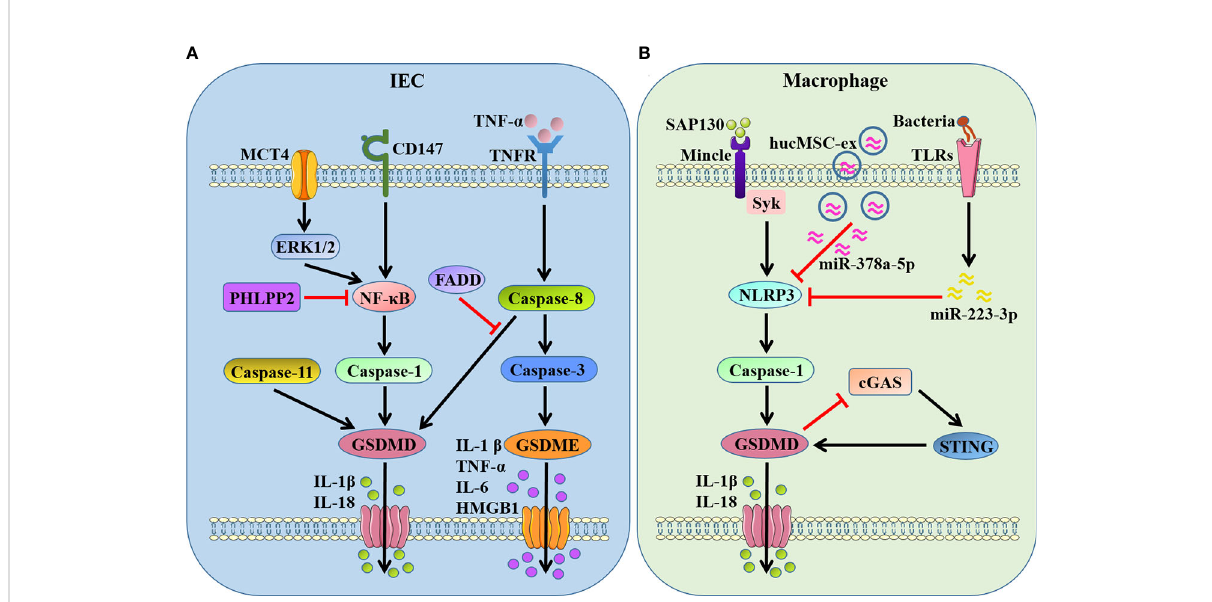
FIGURE 2 GSDMs-mediated pyroptosis in IBD-associated intestinal in fl ammation. (A) GSDMD- and GSDME-dependent pyroptosis in IECs. GSDMD is cleaved by active caspase-1/8/11 when NF- k B being activated by MCT4-ERK1/2 or CD147, promoting the release of IL-1 b and IL-18. PHLPP2 and FADD inhibit GSDMD-dependent pyroptosis by suppressing NF- k B and caspase-8, respectively. GSDME is cleaved by active caspase-3 after caspase-8 activation in response to TNF- a stimulation, promoting the release of proin fl ammatory mediators IL-1 b , TNF- a , IL-6 and HMGB1. (B) GSDMD-dependent pyroptosis in macrophages. GSDMD is cleaved by NLRP3/caspase-1 when Mincle/Syk pathway being activated in response to SAP130, and STING provokes GSDMD cleavage as well. In turn, GSDMD-mediated pyroptosis inhibits cGAS/STING signal.